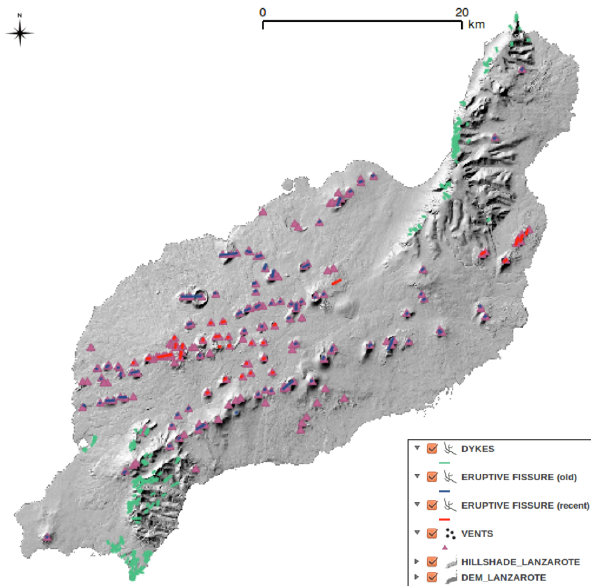
Fig. 5. Main volcano structural data (dykes, vent alignments and emission centers) used to build the susceptibility map of Lanzarote. The topographic base is 25m resolution DEM.